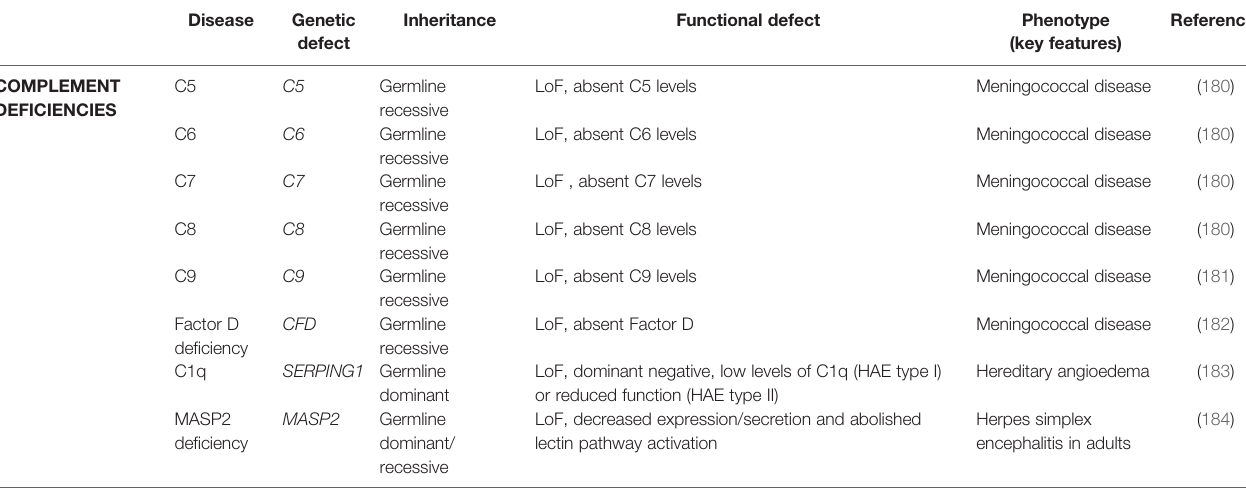
TABLE 7 | Genes associated with adult-onset complement de fi